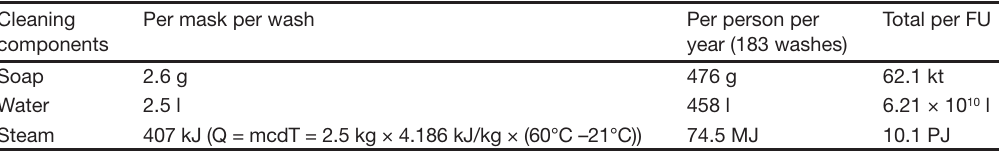
Table A8. Requirements for the manual washing of face masks for Scenarios 2 and